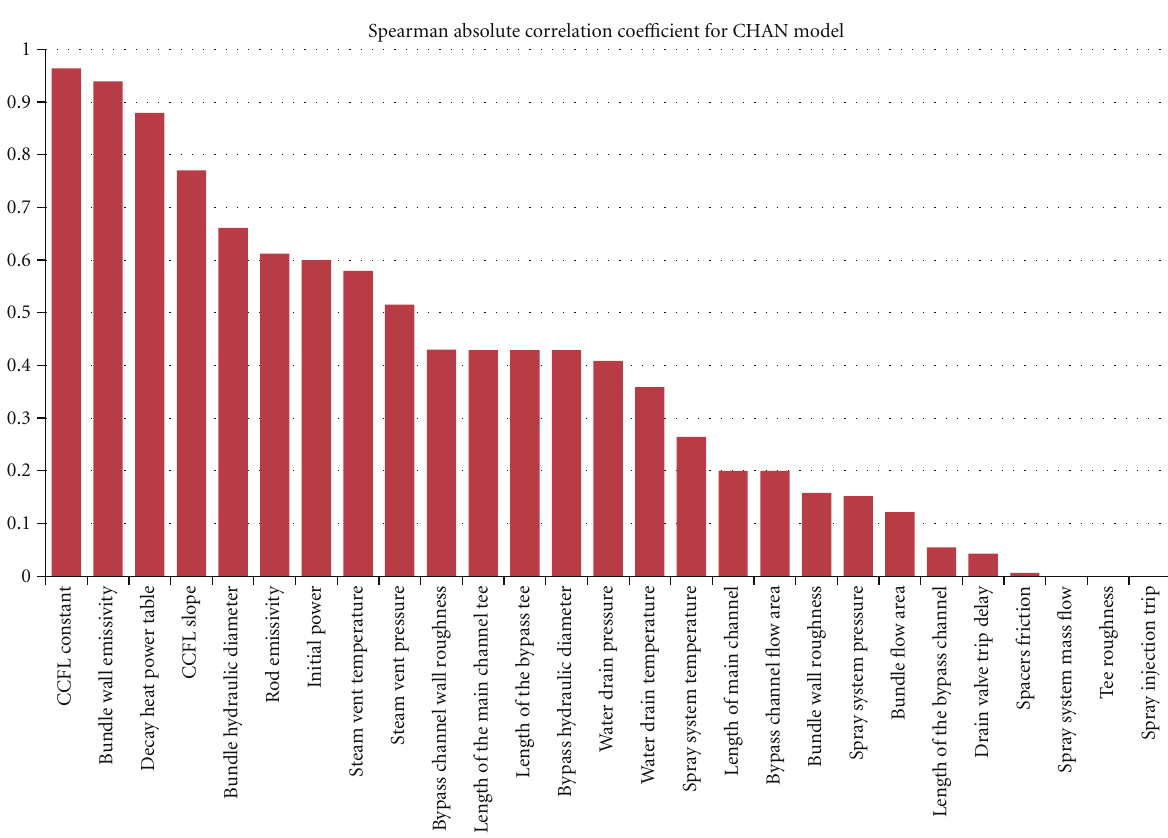
Figure 12: Absolute Spearman correlation coe ffi cients for the PCT for the CHAN